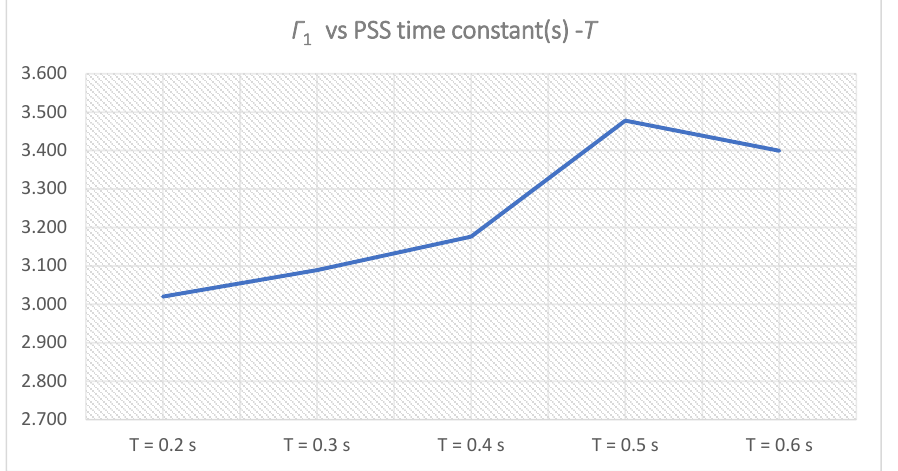
Figure 14. Γ 1 for PSS parameters K = 10, T = Ti, 1 = 0.2 – 0.6 s.